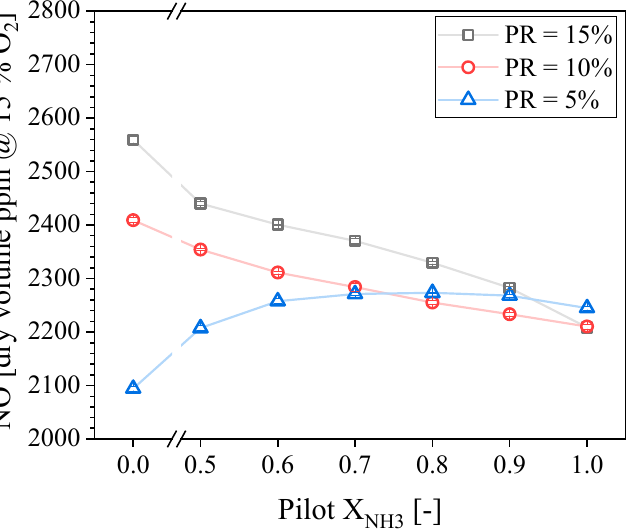
Figure 10. Measured NO concentration in the exhaust gases as a function of the pilot NH 3 for different PRs.